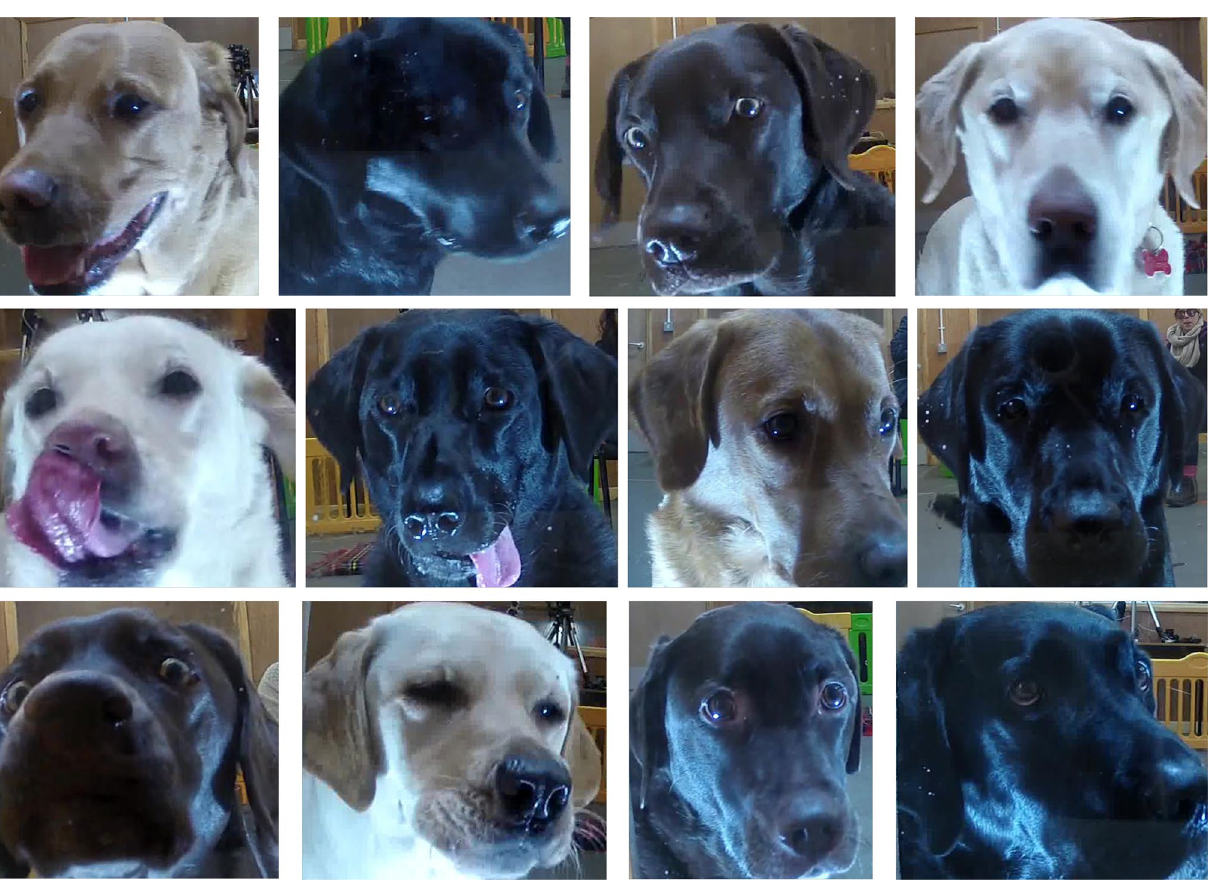
Figure. 2. Example frames from the